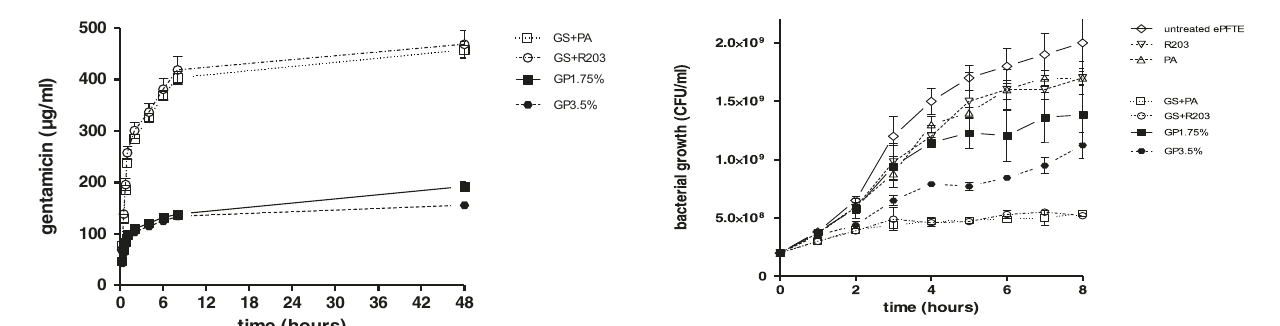
Fig. 2 Gentamicin-release in PBS solution over 48 h for vascular graft coatings using gentamicin in various formulations